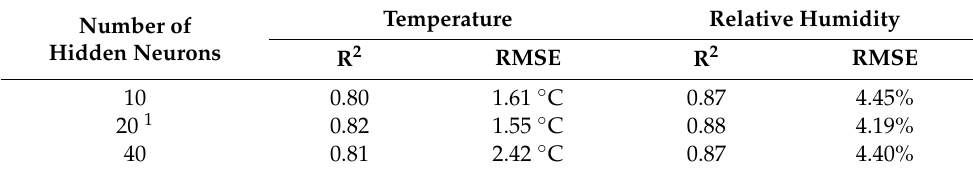
Table 3. Trial-and-error results of the number of hidden neurons in the BPNN model.